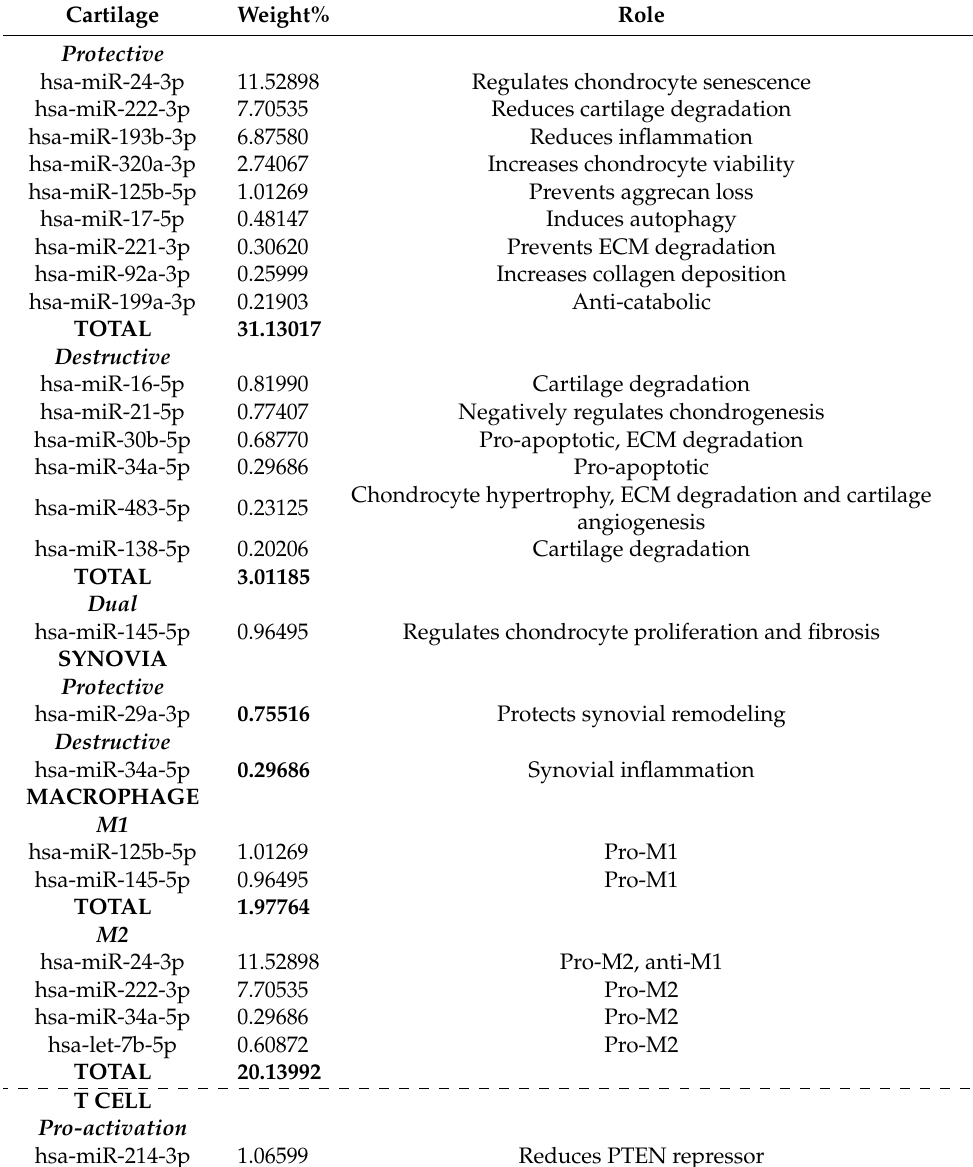
Table 5. EV-miRNAs involved in OA-related cell types and